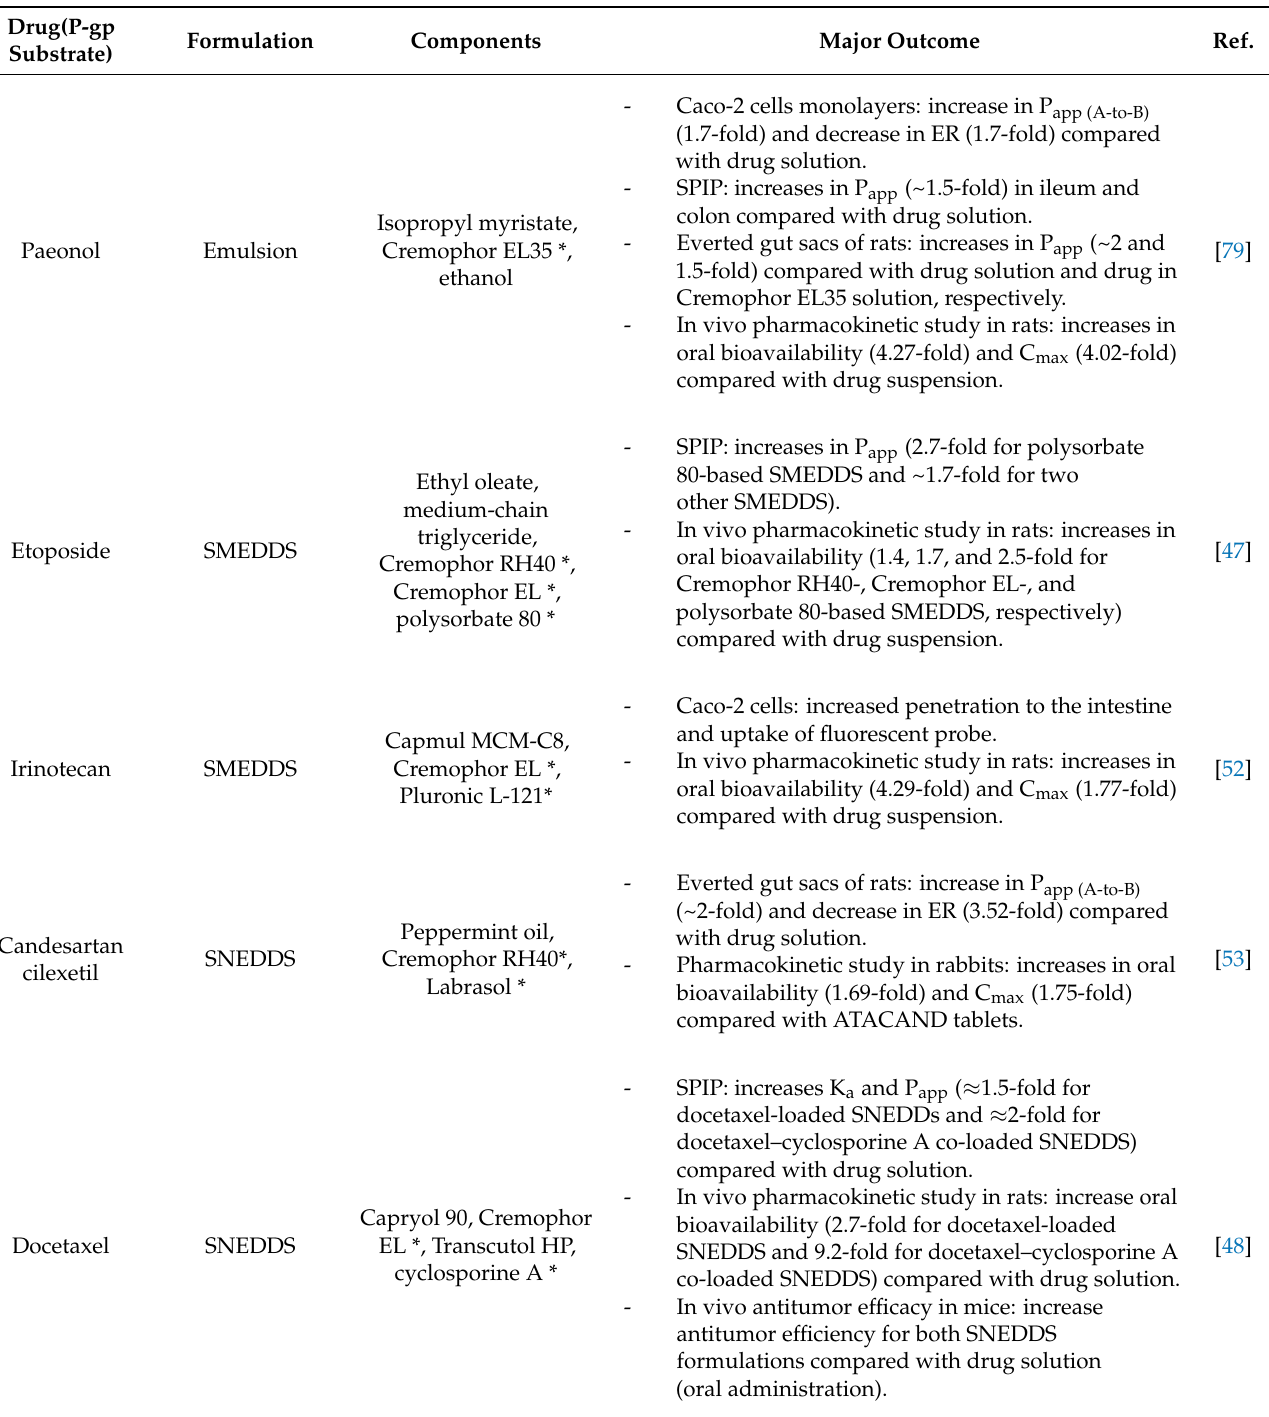
Table 2 summarizes the previous features of some emulsions, SMEDDS, SNEDDS, and liposomes with P-gp inhibitory effects to enhance the oral absorption and bioavailability of various P-gp substrates. Table 2. SMEDDS, SNEDDS, emulsions, and liposomes with P-gp inhibitory